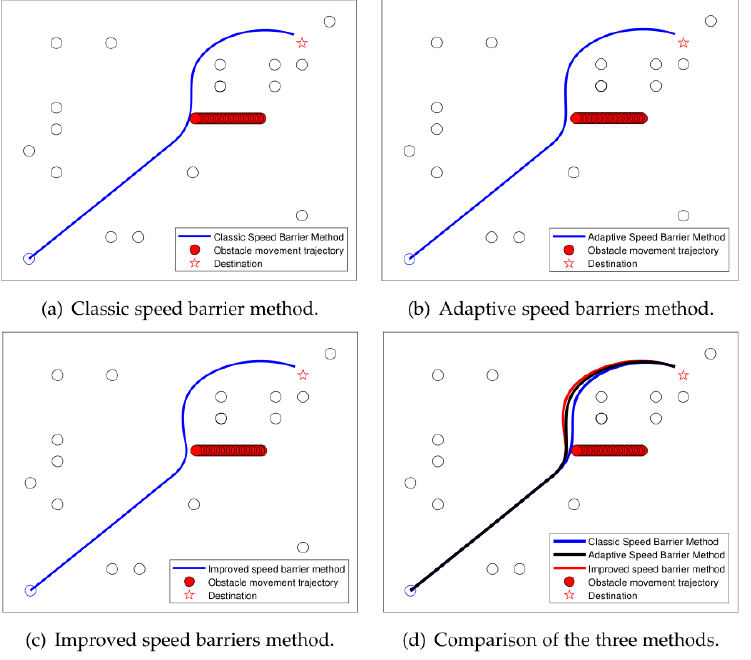
Figure 6. Obstacle avoidance path comparison.